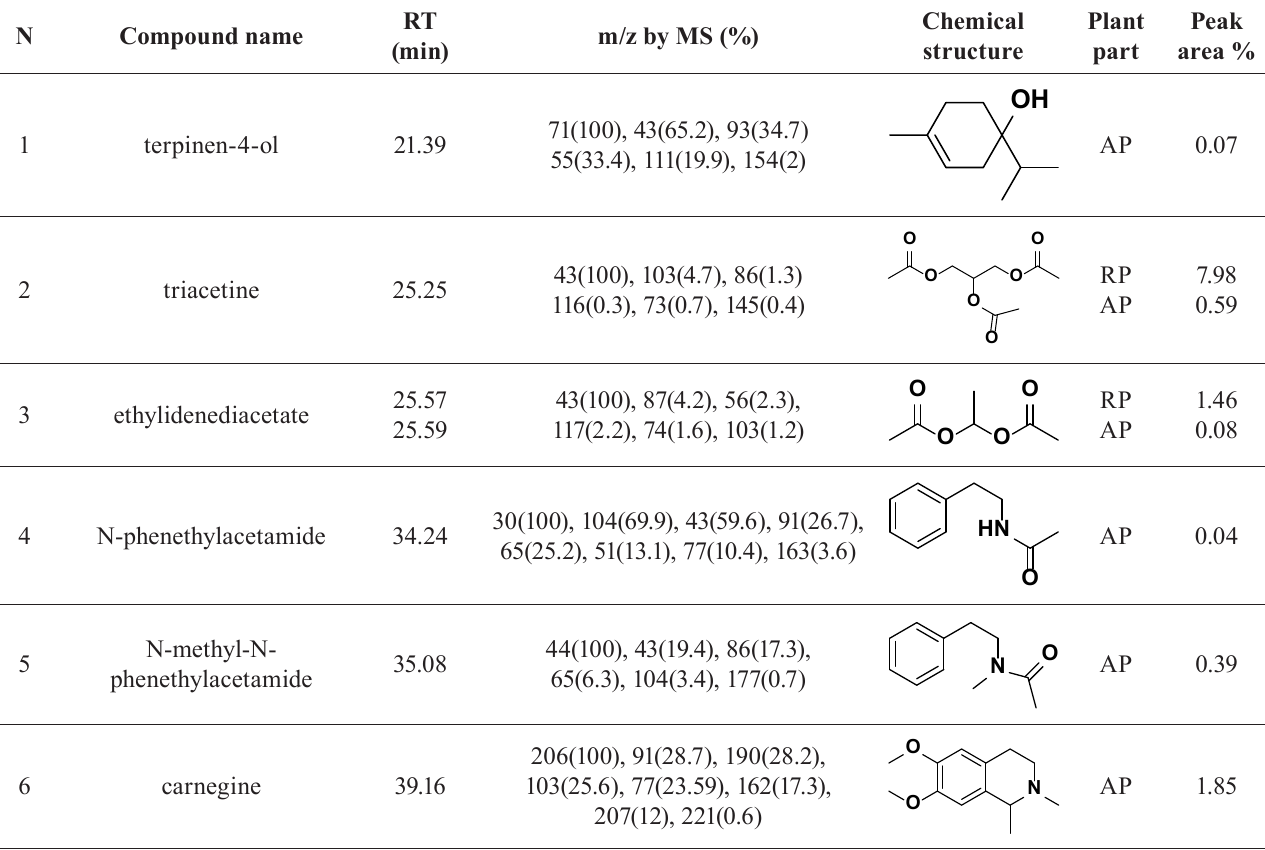
TABLE II - Chemical composition of the acetylated alkaloids extracts (ExAl (2)) obtained in the aerial part (AP) and the root part (RP) of Haloxylon scoparium by the second extraction protocol